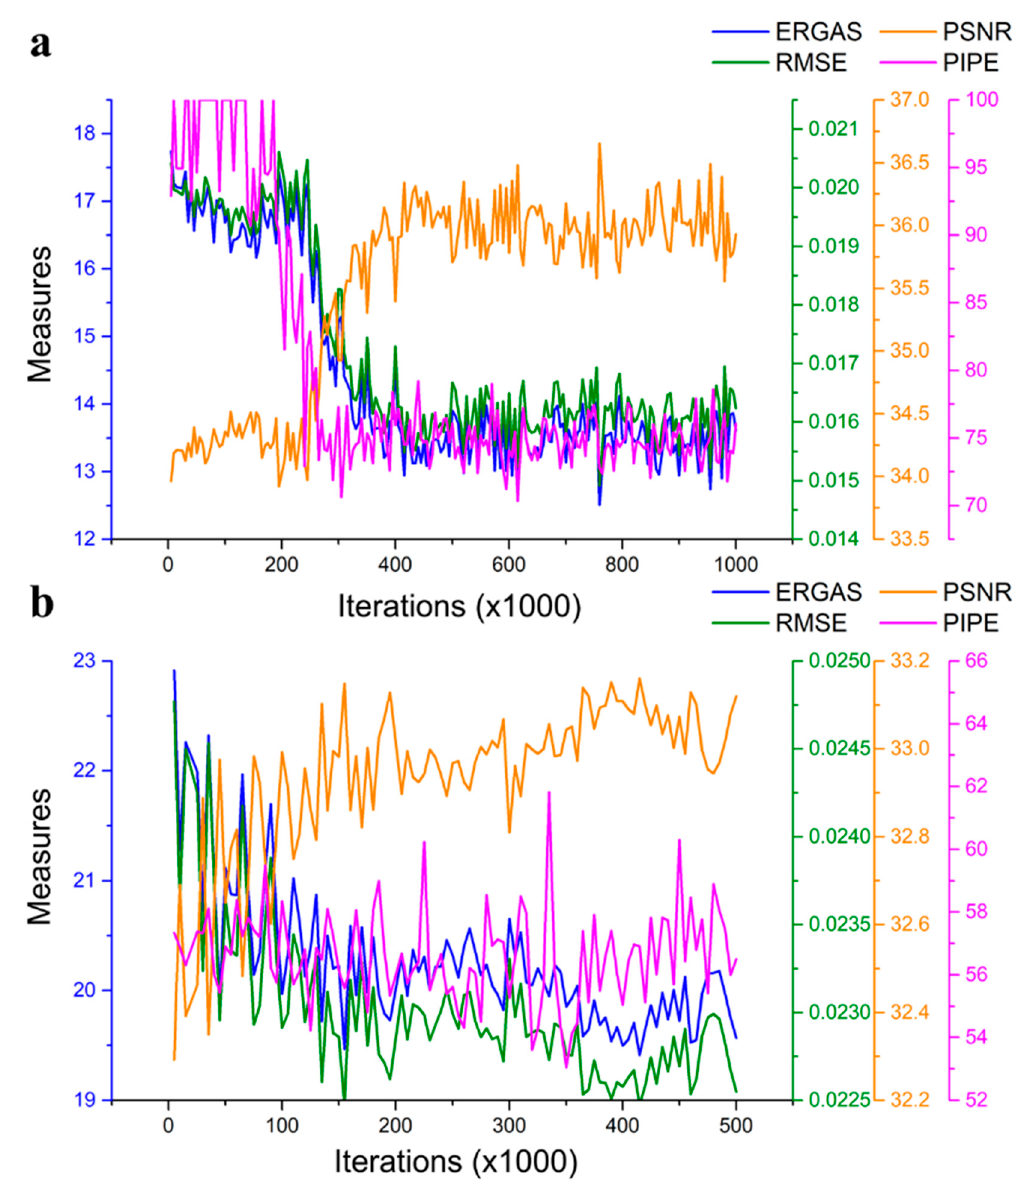
Figure 13. Sensitivity of training iterations to the model performance of ( a ) non-GAN and ( b ) GAN.